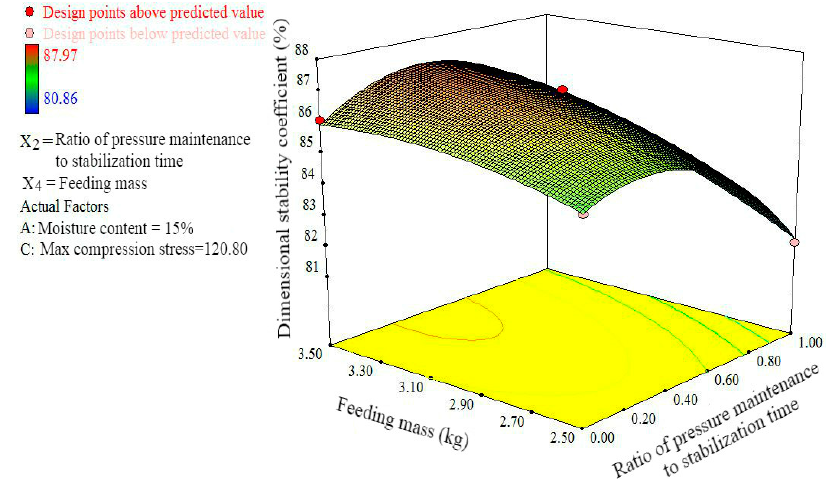
Figure 5. Effects of the ratio of pressure maintenance to stabilization time and feeding mass on dimensional stability coefficient (moisture content of 15% and max compression stress of 180.2 kPa).